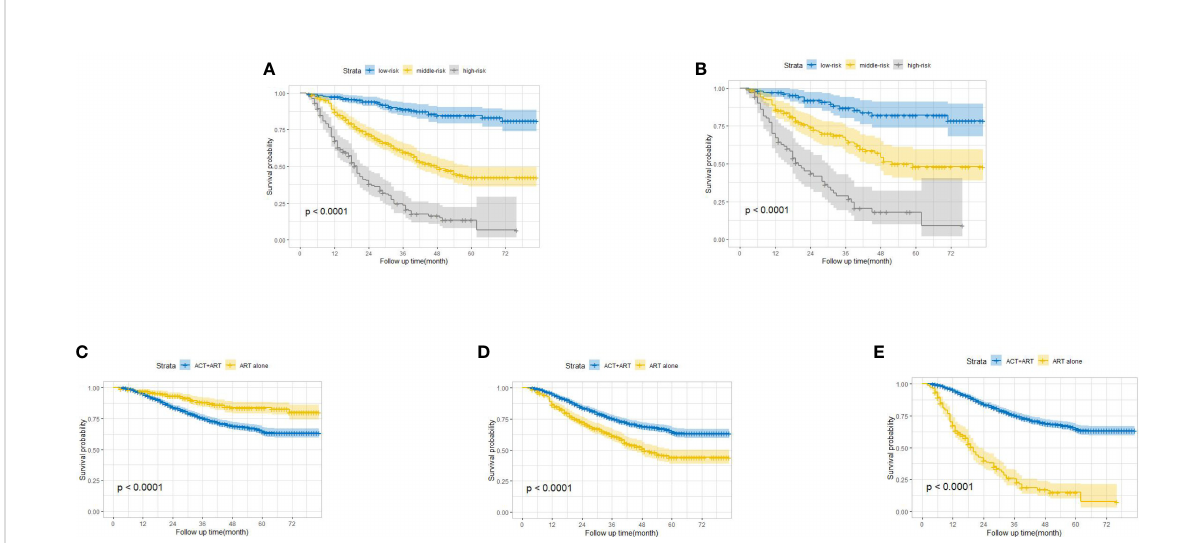
FIGURE 3 Kaplan – Meier overall survival curves for stage IIIC endometrial cancer patients with adjuvant radiotherapy alone strati fi ed by different risks in the training cohort (A) and the validation cohort (B) . Comparison of survival probability between low-risk patients and patients from cohort ART+ACT (C) , middle- risk patients and patients from cohort ART+ACT (D) , and high-risk patients and patients from cohort ART+ACT (E)